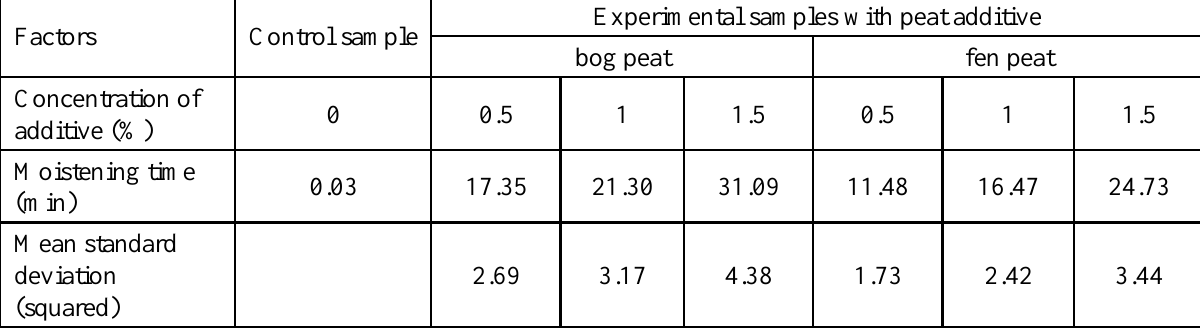
Table 4. Retention times (decimal minutes) of water droplets on the surface of gypsum binder . The values are arithmetic means of the absorption times for 30 drops. Standard deviation (squared) is not shown for the control sample because absorption occurred so rapidly that it was almost impossible to